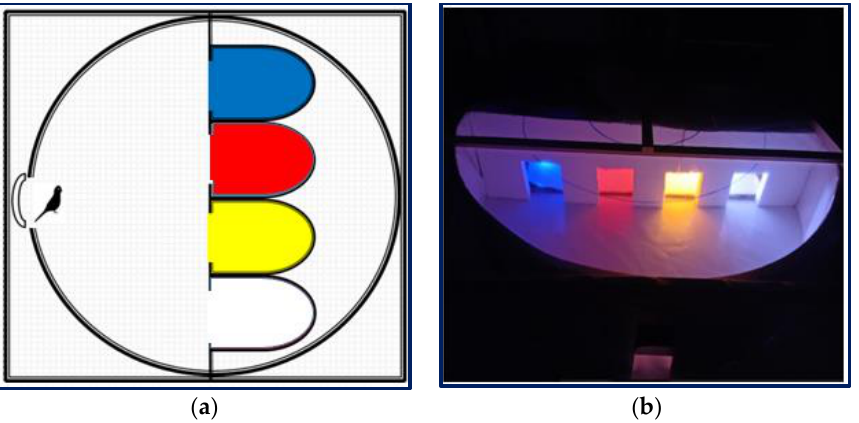
Figure 4. Behavioural analysis platform 2 for OFT II (( a ) diagram, ( b )